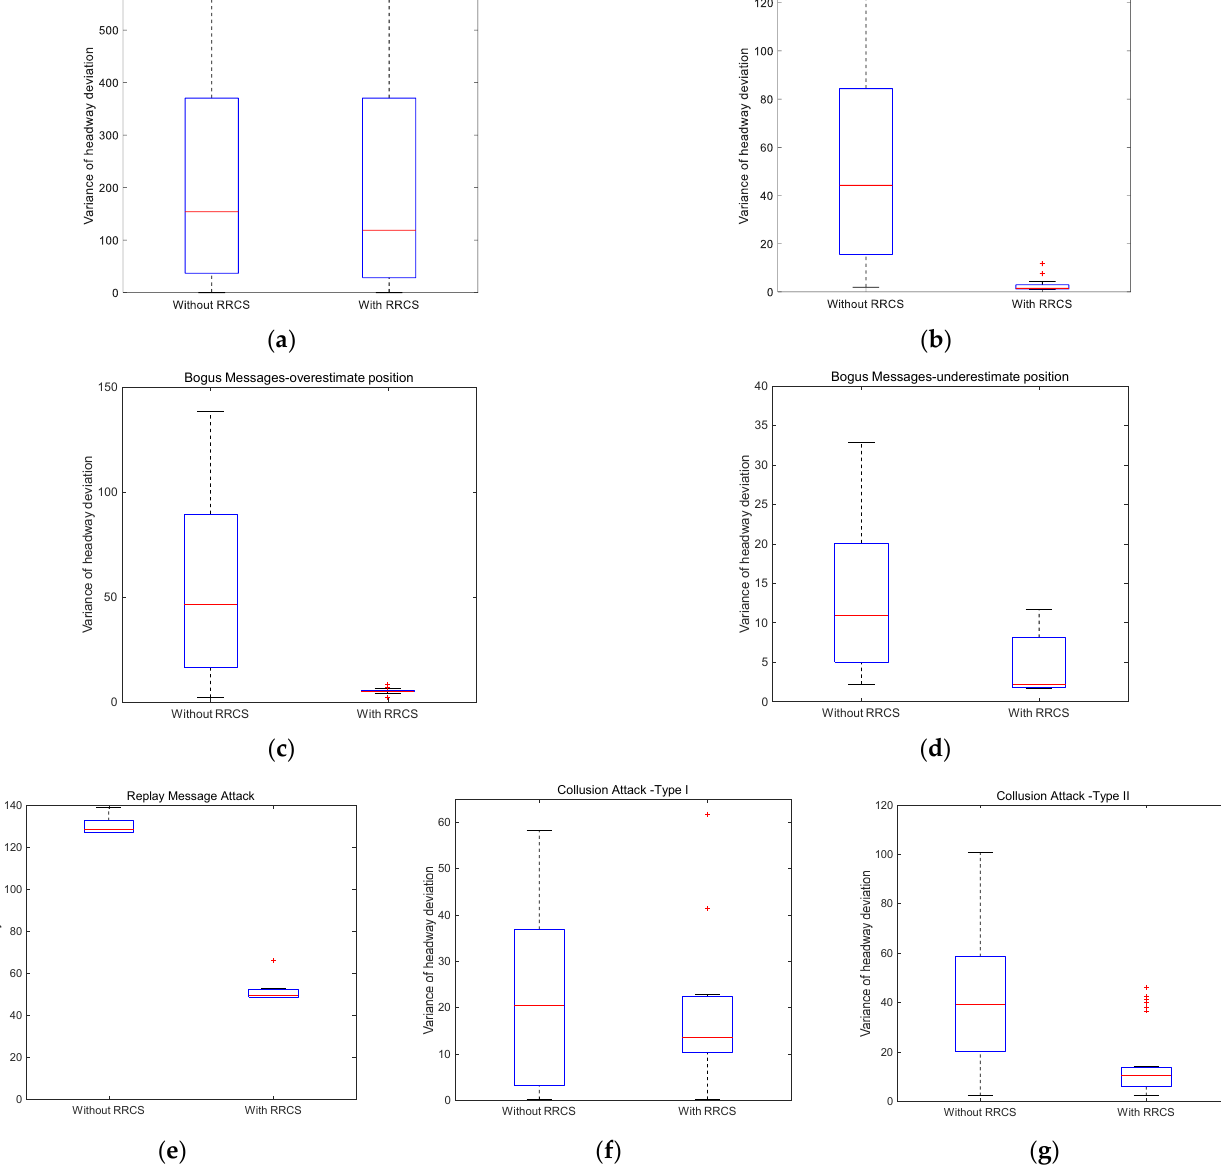
Figure 11. Variance distribution of headway deviation under different cyberattacks scenarios with different cyberattack intensities. Table 6. Box plot data of variance distribution of headway deviation with or without RRCS under different cyberattack intensities.